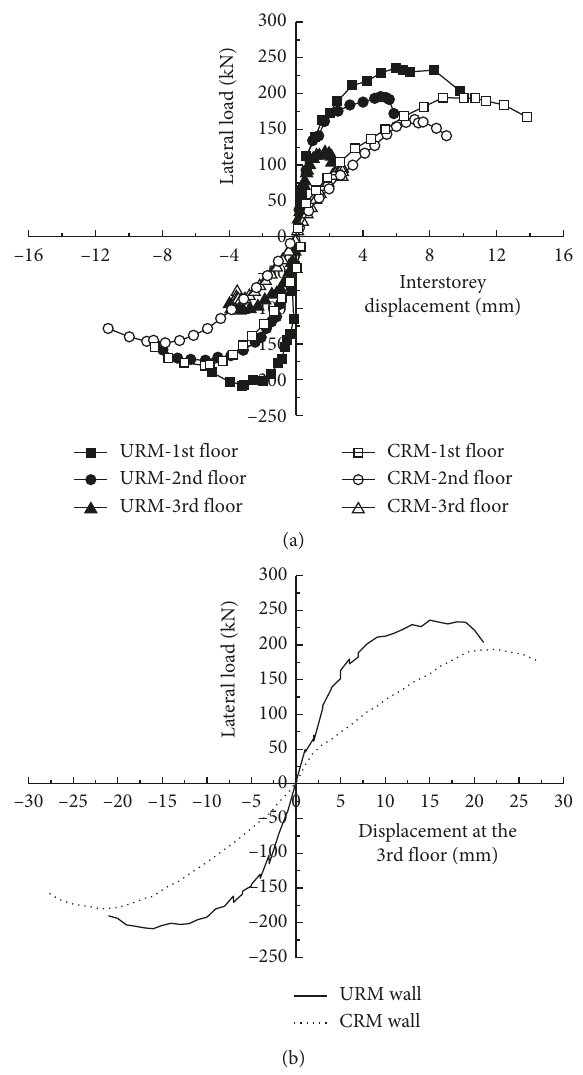
Figure 11: Envelope curves of URM and CRM wall. (a) Envelope curves of each floor. (b) Envelop curves of the entire wall.